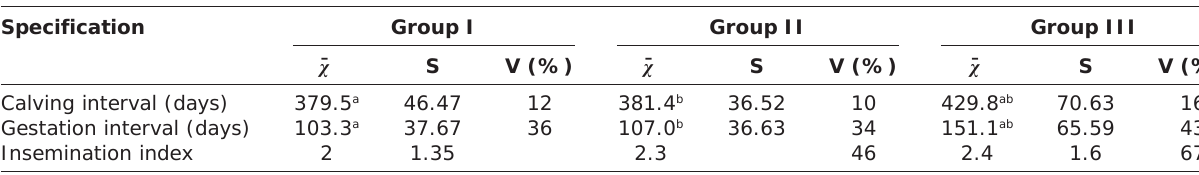
Table-2: The select fertility rates in examined cows.